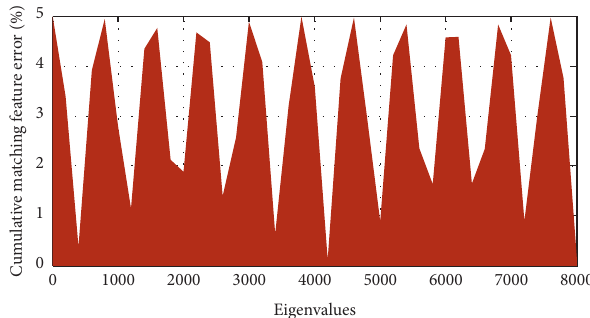
Figure 6: Cumulative matching feature error.